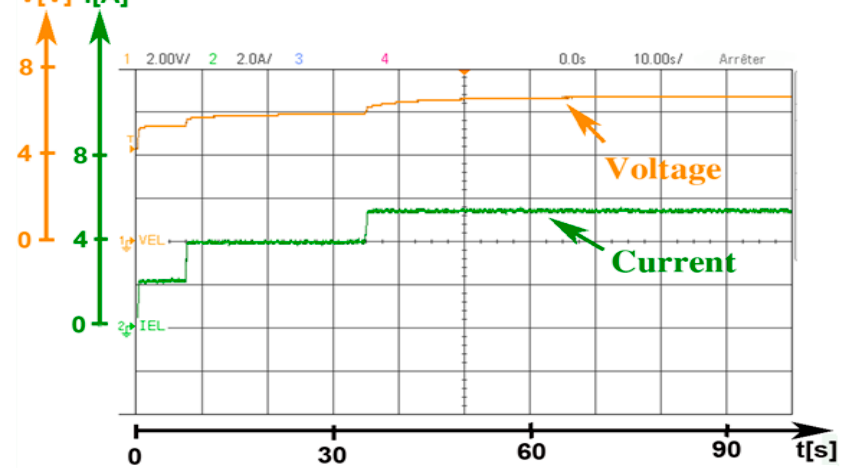
Figure 4. Demonstration of the capacitive effect of the EL. Channel 1: EL voltage (2 V.div − 1 ), channel 2: EL current (2 A.div − 1 ), time: 10 s.div − 1 . Energies 2018 , 11 , x FOR PEER REVIEW